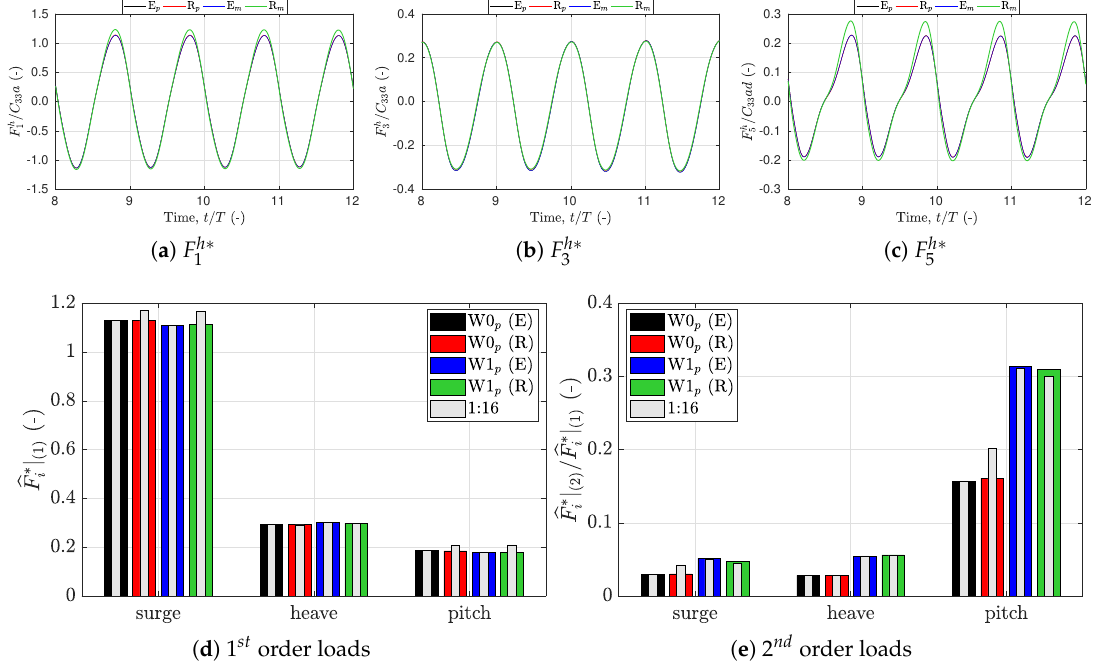
Figure 4. Hydrodynamic forces acting on the fixed WEC. ( a – c ) are time histories in the W1 wave. ( d ) is first order amplitudes, and ( e ) is second order amplitudes relative to the first order. Coloured bars are prototype results and thinner grey bars are the model scale (1:16) results. See Table 4 for non-dimensionalisation